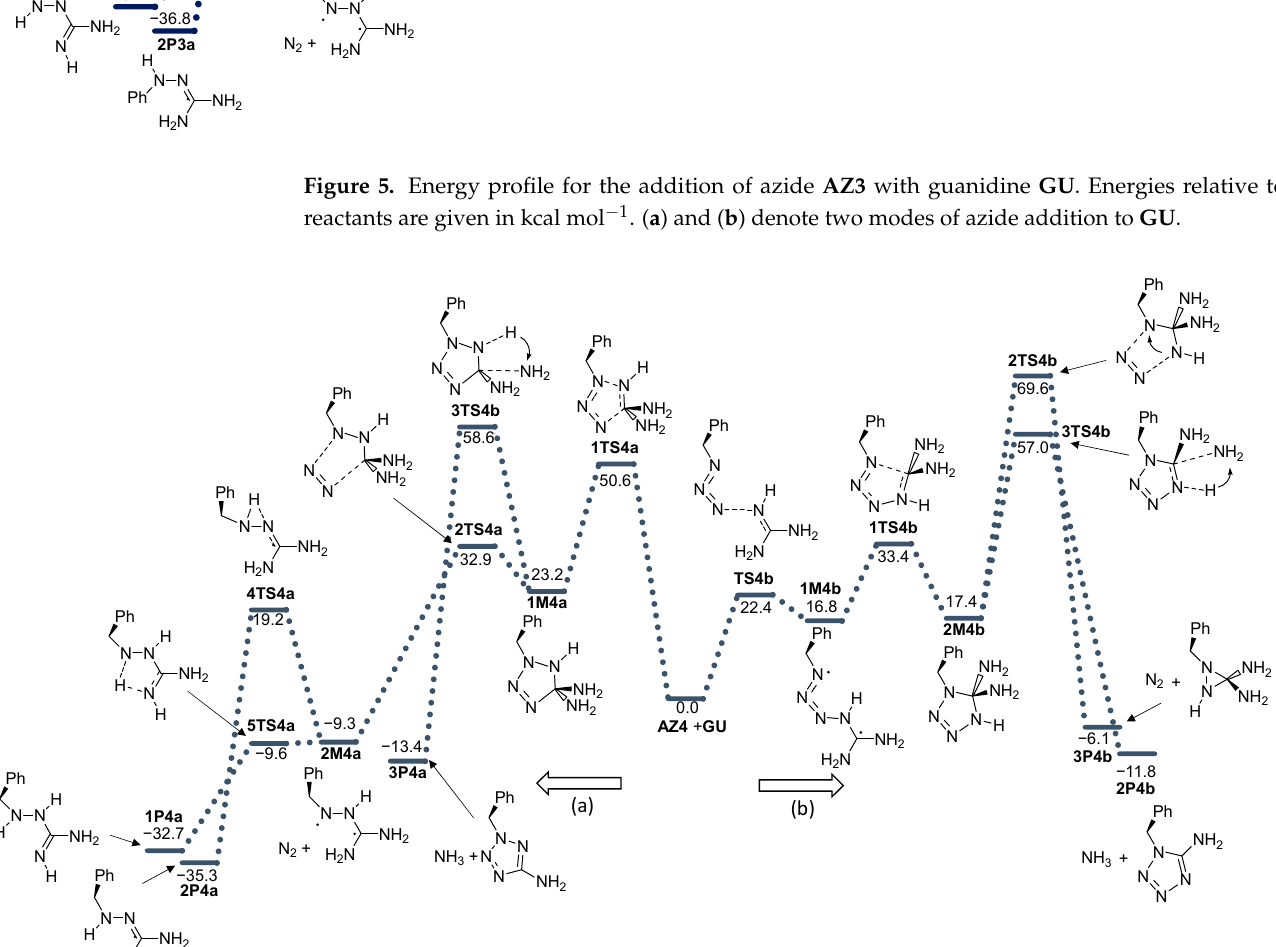
Figure 6. Energy profile for the addition of azide AZ4 with guanidine GU . Energies relative to reactants are given in kcal mol − 1 . ( a ) and ( b ) denote two modes of azide addition to GU